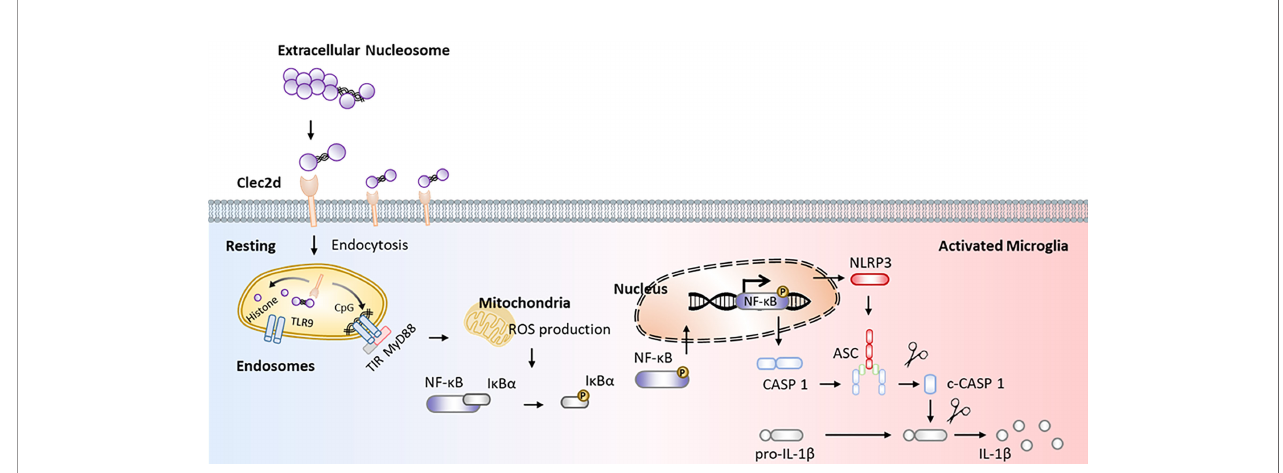
FIGURE 9 | Graphical summary. Working model illustrating extracellular nucleosomes promoted microglial ROS production, primed NF- k B signaling pathway, and activated NLRP3 in fl ammasome via Clec2d and TLR9 in mPFC during chronic